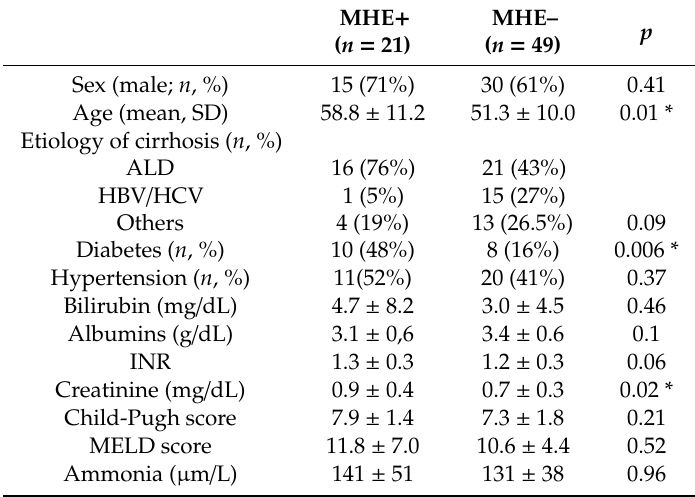
Table 1. Characteristics of patients with MHE diagnosed based on PHES.